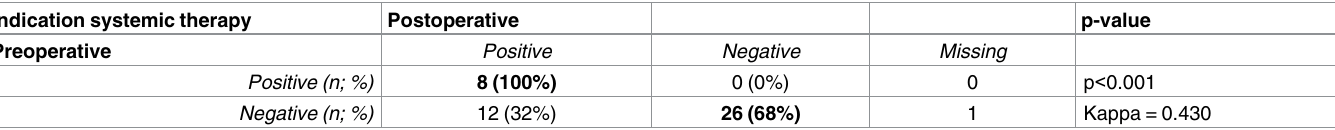
Table 4. Association between the preoperative and postoperative indication for systemic therapy based on conventional diagnostic workup.